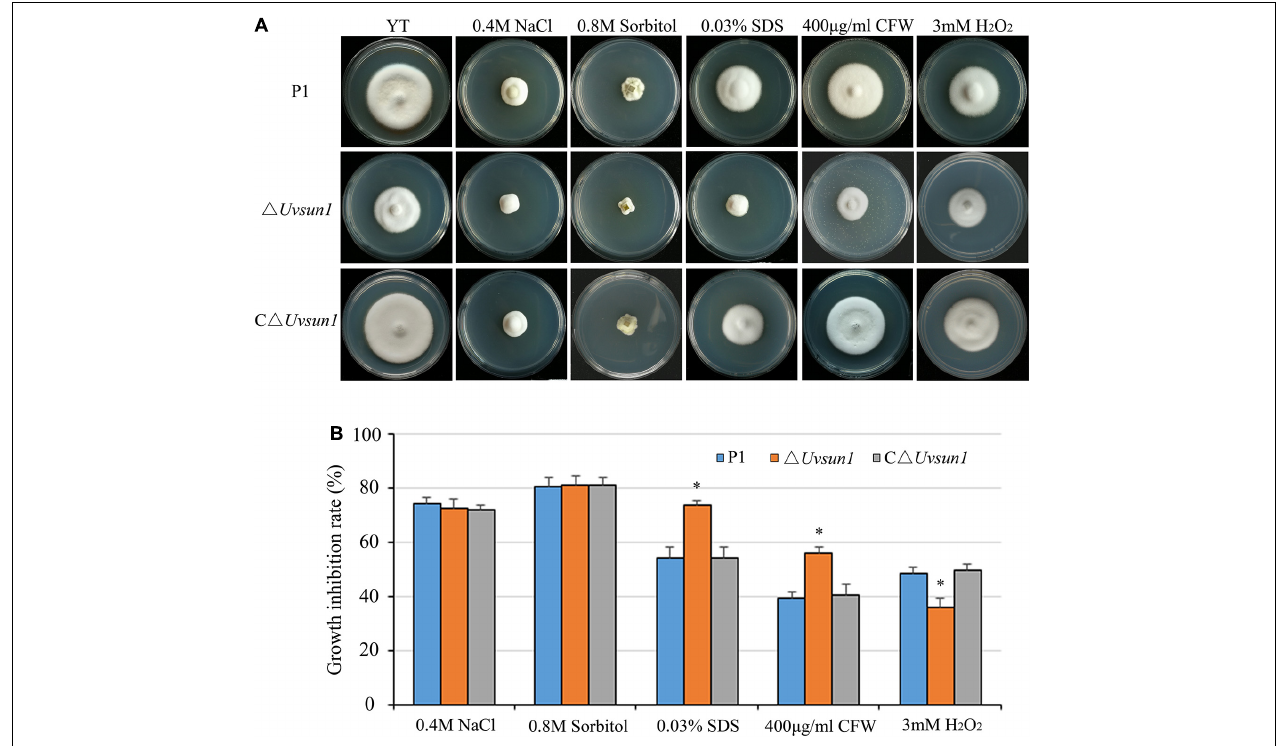
FIGURE 3 | Uvsun1 is involved in regulating pathogen stress responses. (A) Mycelial radial growth of the indicated wild-type P1, (cid:77) Uvsun1 and the complemented C (cid:77) Uvsun1 strain on YT medium supplemented with salt stress agent (0.4 M NaCl), osmotic stress agent (0.8 M Sorbitol), oxidative-stress agent (3 mM H 2 O 2 ), and cell wall disturbing agents Calcofluor white (CFW, 400 mg/mL) and sodium dodecyl sulfate (0.03% SDS). Photographs were taken after 12 days of incubation at 28 ◦ C. (B) Statistical analysis of the indicated strains growth inhibition rate under different stress conditions. Colony diameters of the indicated strains were measured. Data are shown as mean ± SD of three independent replicates. Asterisks indicate significant differences (one-way ANOVA, ∗ p <